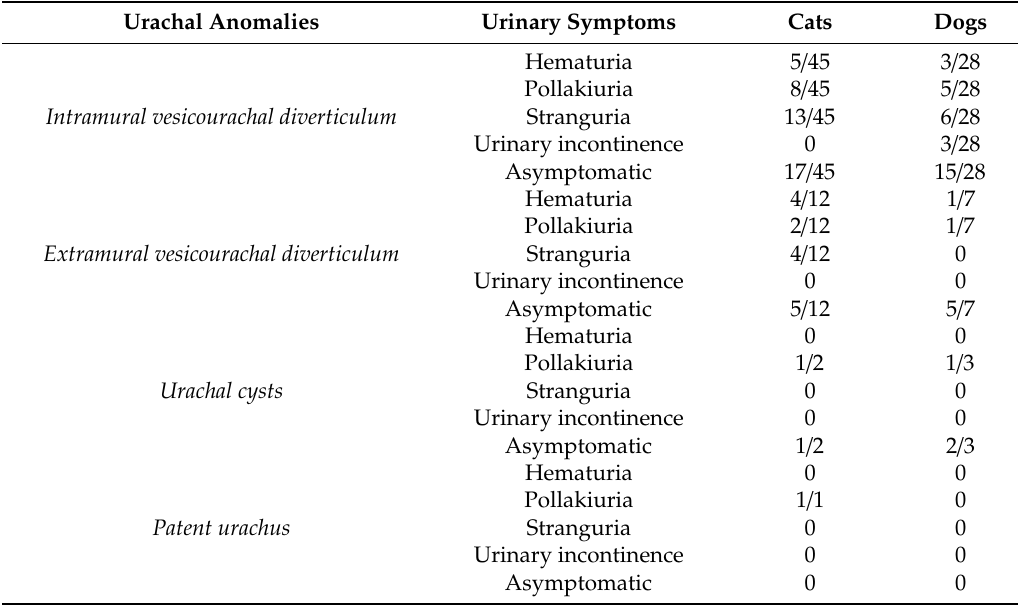
Table 3. Prevalence of clinical urinary findings in all patients included with di ff erent type of urachal anomalies. Urachal